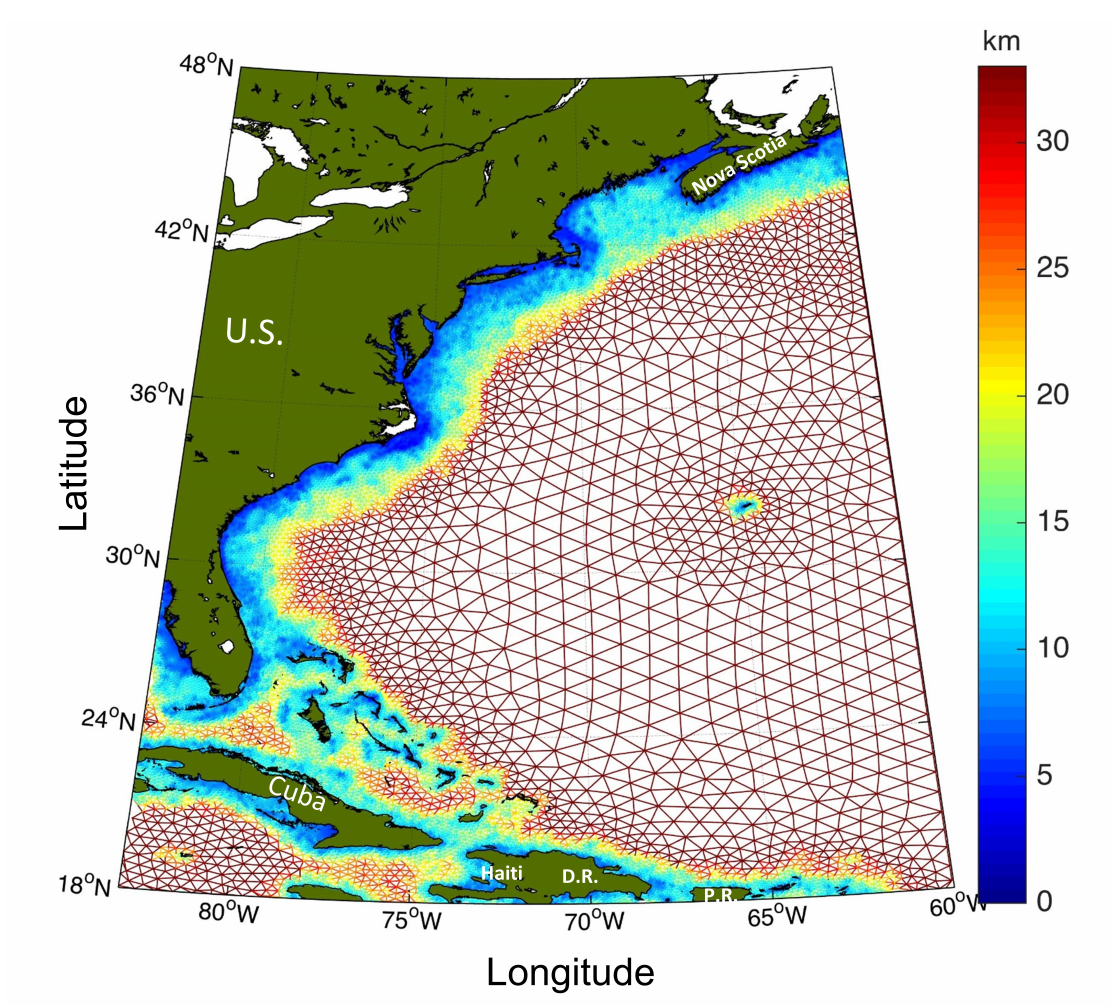
Figure 1. Spatial resolution of an unstructured grid in western North Atlantic region used in ADCIRC Surge Guidance System